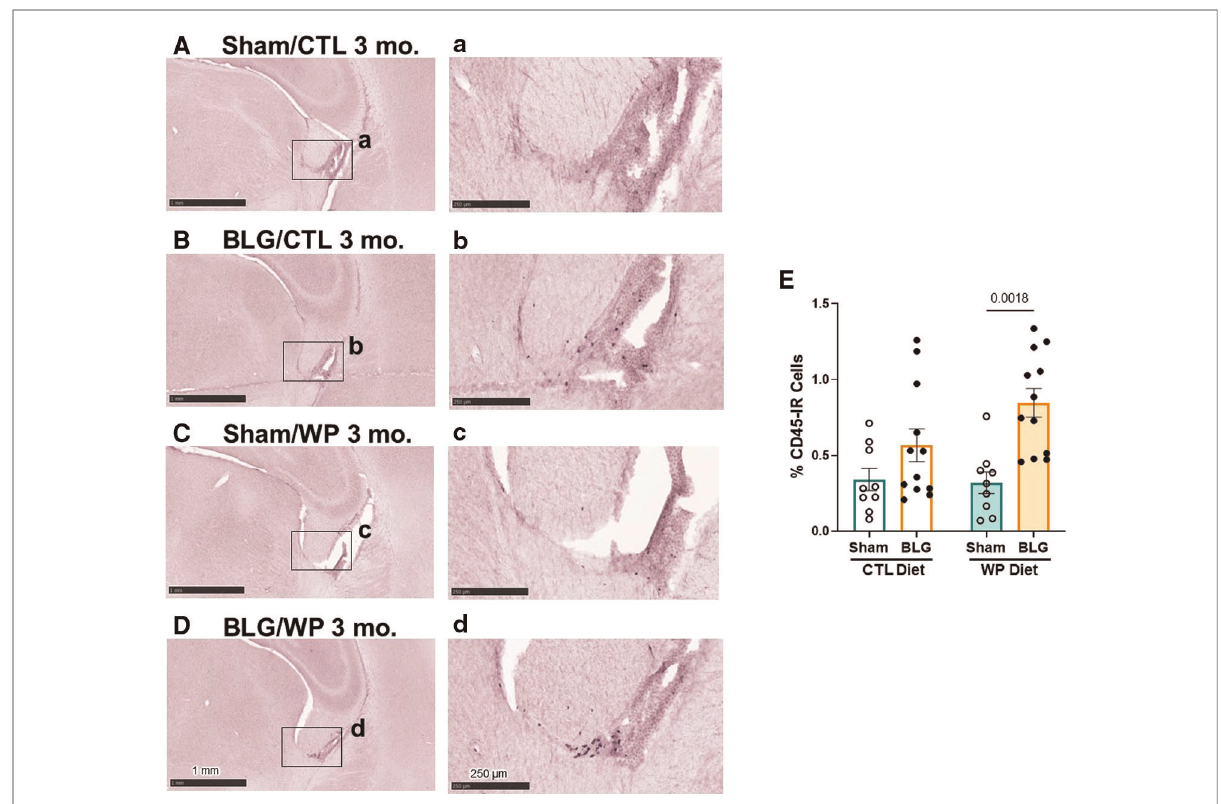
FIGURE 6 CD45-immunoreactive leukocytes in the brain. Brain sections from the experimental mice were immunostained for CD45. Representative staining from sham mice with the CTL diet ( A ), BLG mice with the CTL diet ( B ), sham mice with the WP diet ( C ), and BLG mice with the WP diet ( D ) are shown. Images of the fi mbria within the lateral ventricles ( A – D ) were taken at higher magni fi cation from the region indicated by the black rectangles in the corresponding photomacrographs ( A – D ). The images were taken with 1.5X ( A – D ) or 10X ( a – d ) objectives. Scale bars: 1 mm ( A – D ); 250 μ m ( a – d ). The percentages of CD45-IR cells within the fi mbria region were quanti fi ed using the QuPath image analysis software ( E ). Values indicate the group average±SEM. Signi fi cant p -values are shown. Two-way ANOVA, n =9 – 12 per